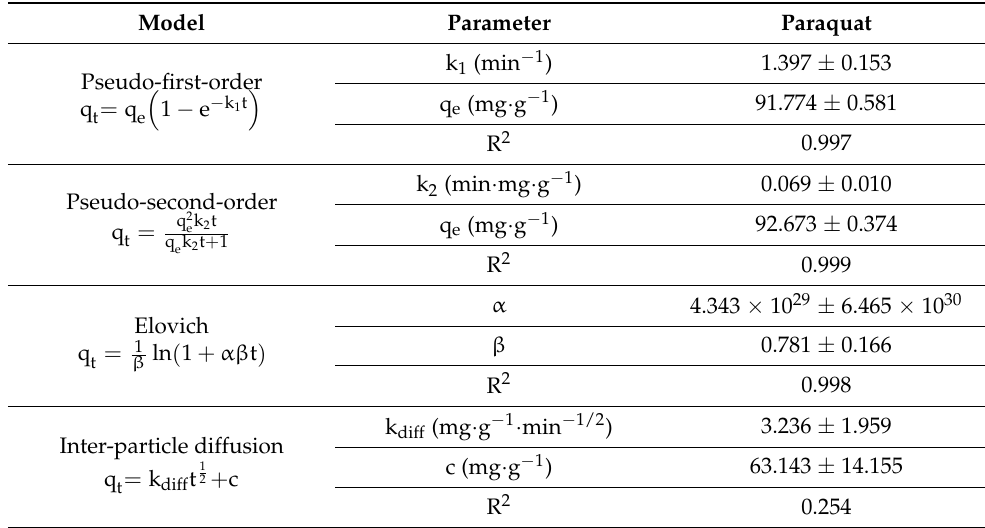
Figure 11. Adsorption curves for paraquat adsorption onto OPL − KOH − 800 − 1:4: ( a ) effect of adsorption time on the adsorption capacity; ( b ) curves of the adsorption kinetics. Table 7. Adsorption kinetic parameters of